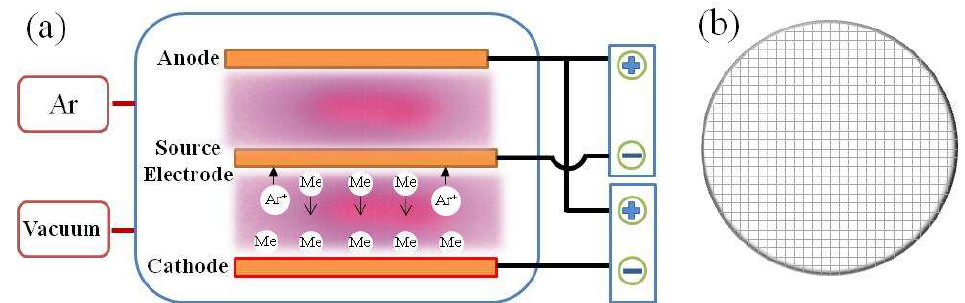
Figure 1. The schematic diagram of double glow plasma surface metallurgy (DGPSM) technology ( a ) and the mesh structure of the source electrode ( b ).